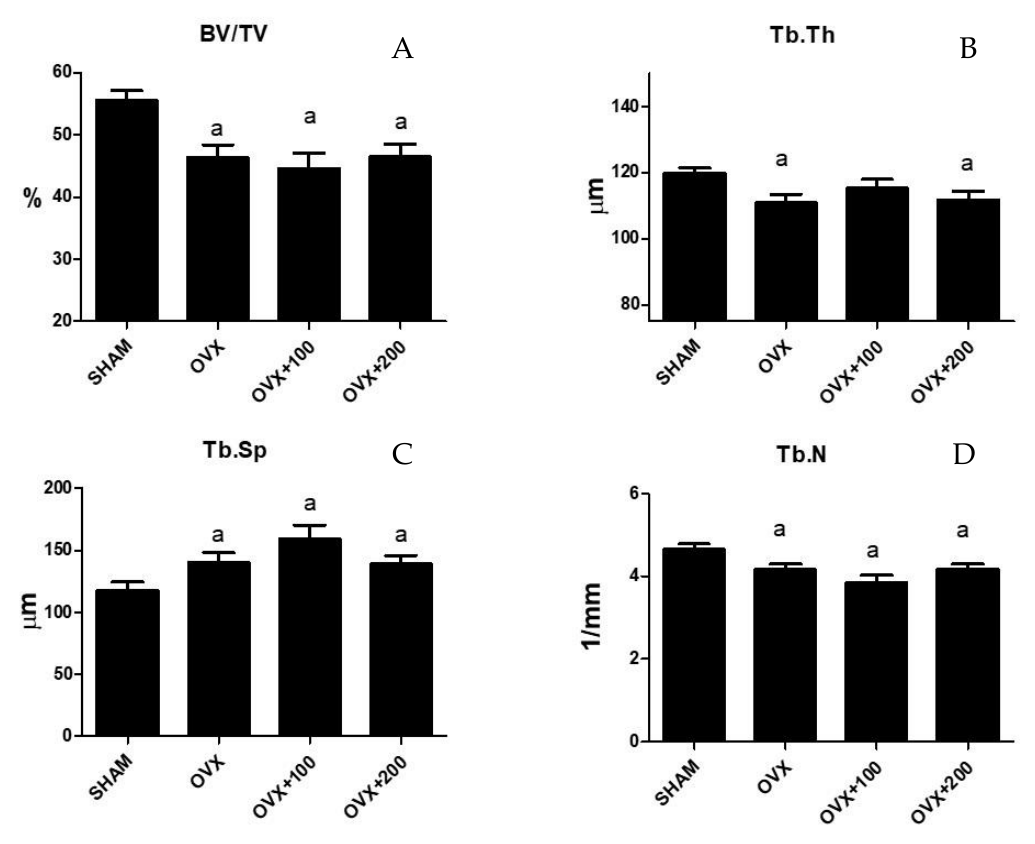
Figure 2. Femoral trabecular microarchitecture analysis: bone volume / total volume (BV / TV) ( A ), trabecular thickness (Tb.Th) ( B ), trabecular separation (Tb.Sp) ( C ), and trabecular number (Tb.N) ( D ). SHAM operated, ovariectomized (OVX), ovariectomized and treated with olive oil (OVX + 100) (100 µ L / day by oral gavage) and ovariectomized and treated with olive oil (OVX + 200) (200 µ L / day by oral gavage) over 3 months, n = 12. Data are expressed as mean ± SD. Statistical significance: ( a ) vs. SHAM. BV / TV: OVX vs. SHAM p < 0.01, OVX + 100 vs. SHAM p < 0.001, OVX + 200 vs. SHAM p <